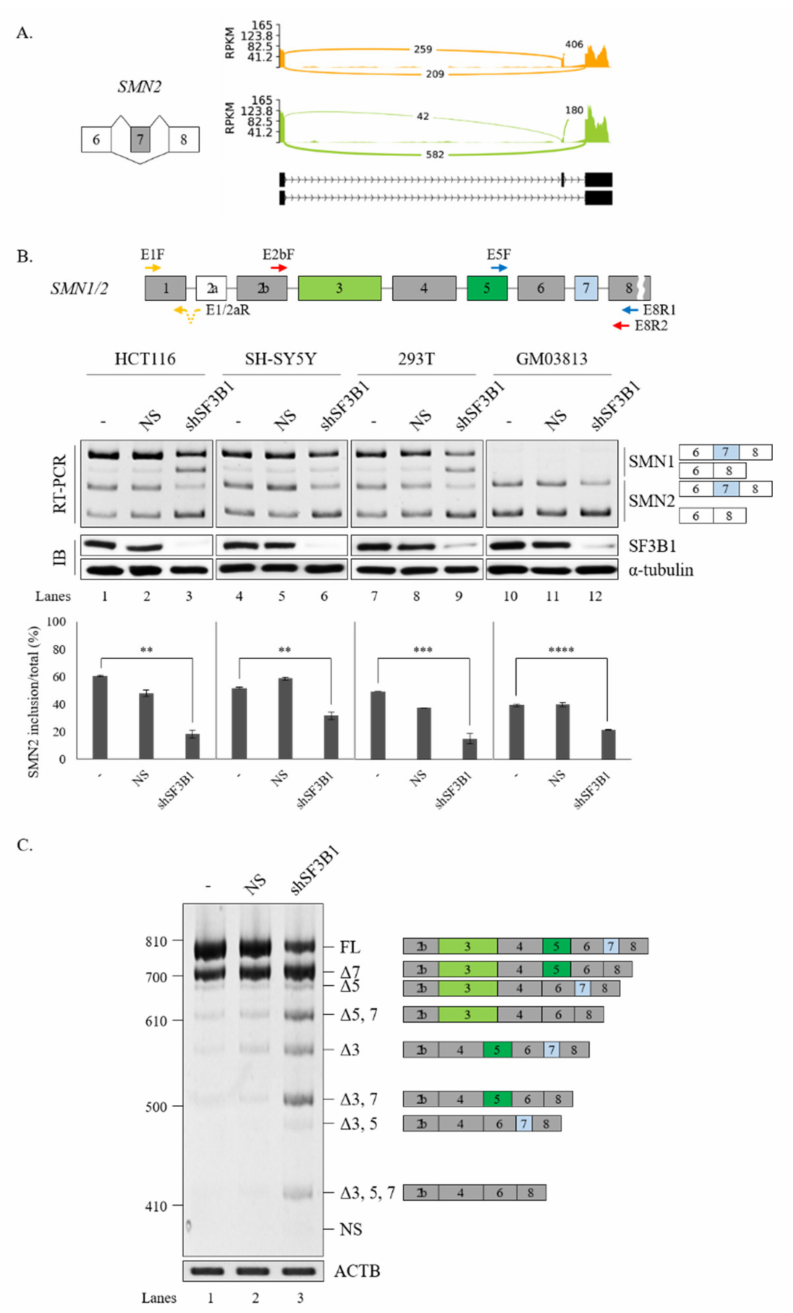
Figure 4. SF3B1 regulates AS of SMN pre-mRNA. ( A ) Sashimi plots of SMN2 pre-mRNA splicing in RNA-seq of SF3B1 KD cells. ( B ) (Upper) location of primer annealing in RT-PCR. (Lower) RT-PCR analysis of SMN1 and SMN2 pre-mRNA splicing with primers E5F and E8R1 in HCT116, SH-SY5Y, HEK293T, and SMA patient (GM03813) cells treated with an SF3B1-targeting shRNA. Reduced SF3B1 expression levels by the shRNA are shown with RT-PCR and immunoblotting using ACTB and α -tubulin as controls. Statistical analysis results of RT-PCR are shown with p -values: **** p < 0.0001; *** p < 0.001; ** p < 0.01; and * p < 0.05. ( C ) Analysis of multiple exon splicing in HEK293T cells using the MESDA and primers E2bF and E8R2 with ACTB as a control. Alternatively spliced exons are labeled with green or blue